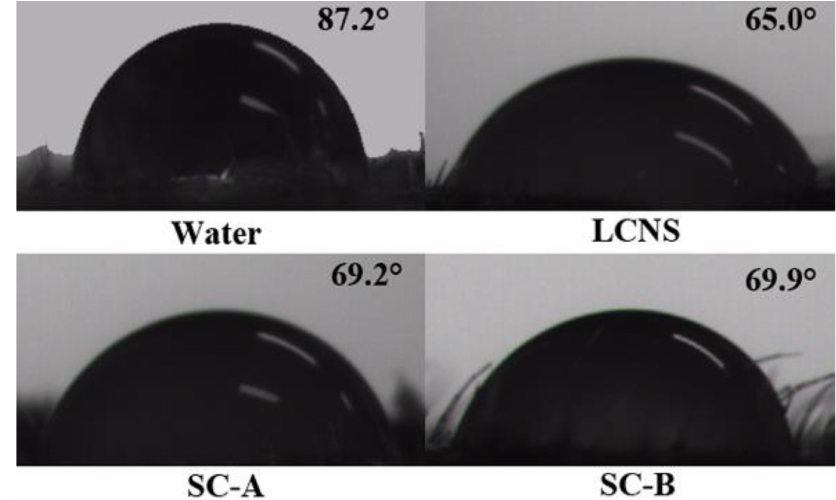
Figure 3. Contact angles image of different lambda-cyhalothrin formulations on cucumber leaves.